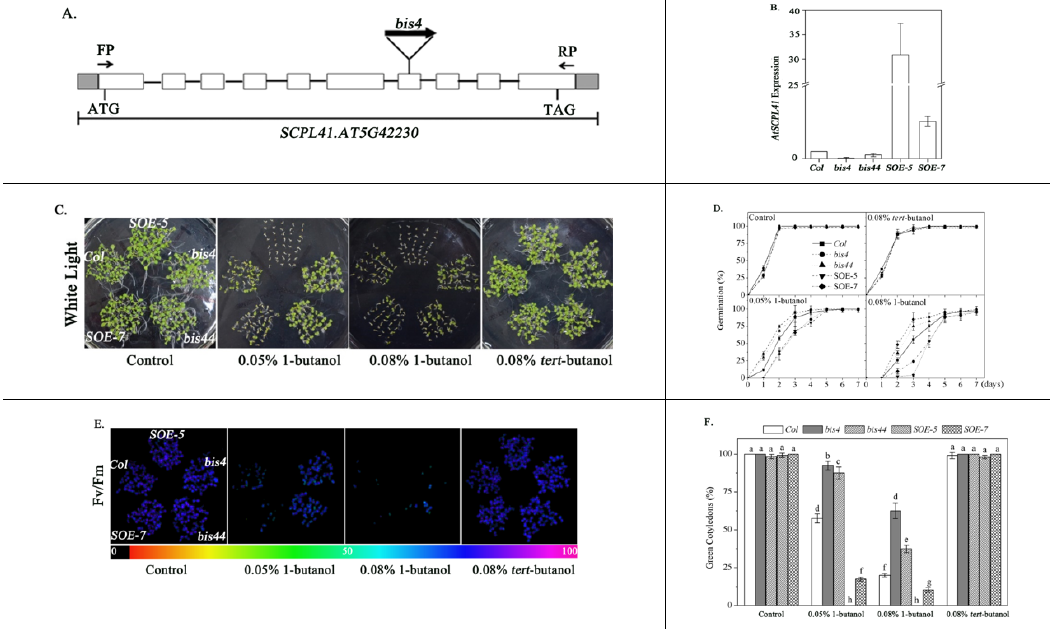
Figure 1. Seed germination and postgerminative growth of Col, bis4, bis44, SOE-5, and SOE-7 plants in response to 1-butanol. ( A ) Gene structure of AT5g42230 . The filled boxes indicate exons, and the lines indicate introns. The sites of insertion in the bis4 mutant are marked. ( B ) Quantitative PCR analysis of SCPL41 expression in 7-d-old Col , bis4 , bis44 , SOE-5 , and SOE- 7 mutant seedlings in the absence of 1-butanol. The values are the means ± SDs ( n = 3). ( C ) Visual comparison of Col , bis4 , bis44, SOE-5, and SOE-7 seed germination and postgerminative growth after 7 d in the absence or presence of 0.05% 1-butanol, 0.08% 1-butanol, or 0.08% tert -butanol. ( D ) Germination rate of Col wild-type as well as bis4 , bis44 , SOE-5 , and SOE-7 plants in the absence or presence of 0.08% 1-butanol or 0.08% tert -butanol at the indicated times. ( E ) F v / F m values. The color bar on the bottom indicates the F v / F m values. ( F ) Green cotyledons were scored after 7 d of growth and represent an average of 120 seeds of at least three independent experiments ± SDs.